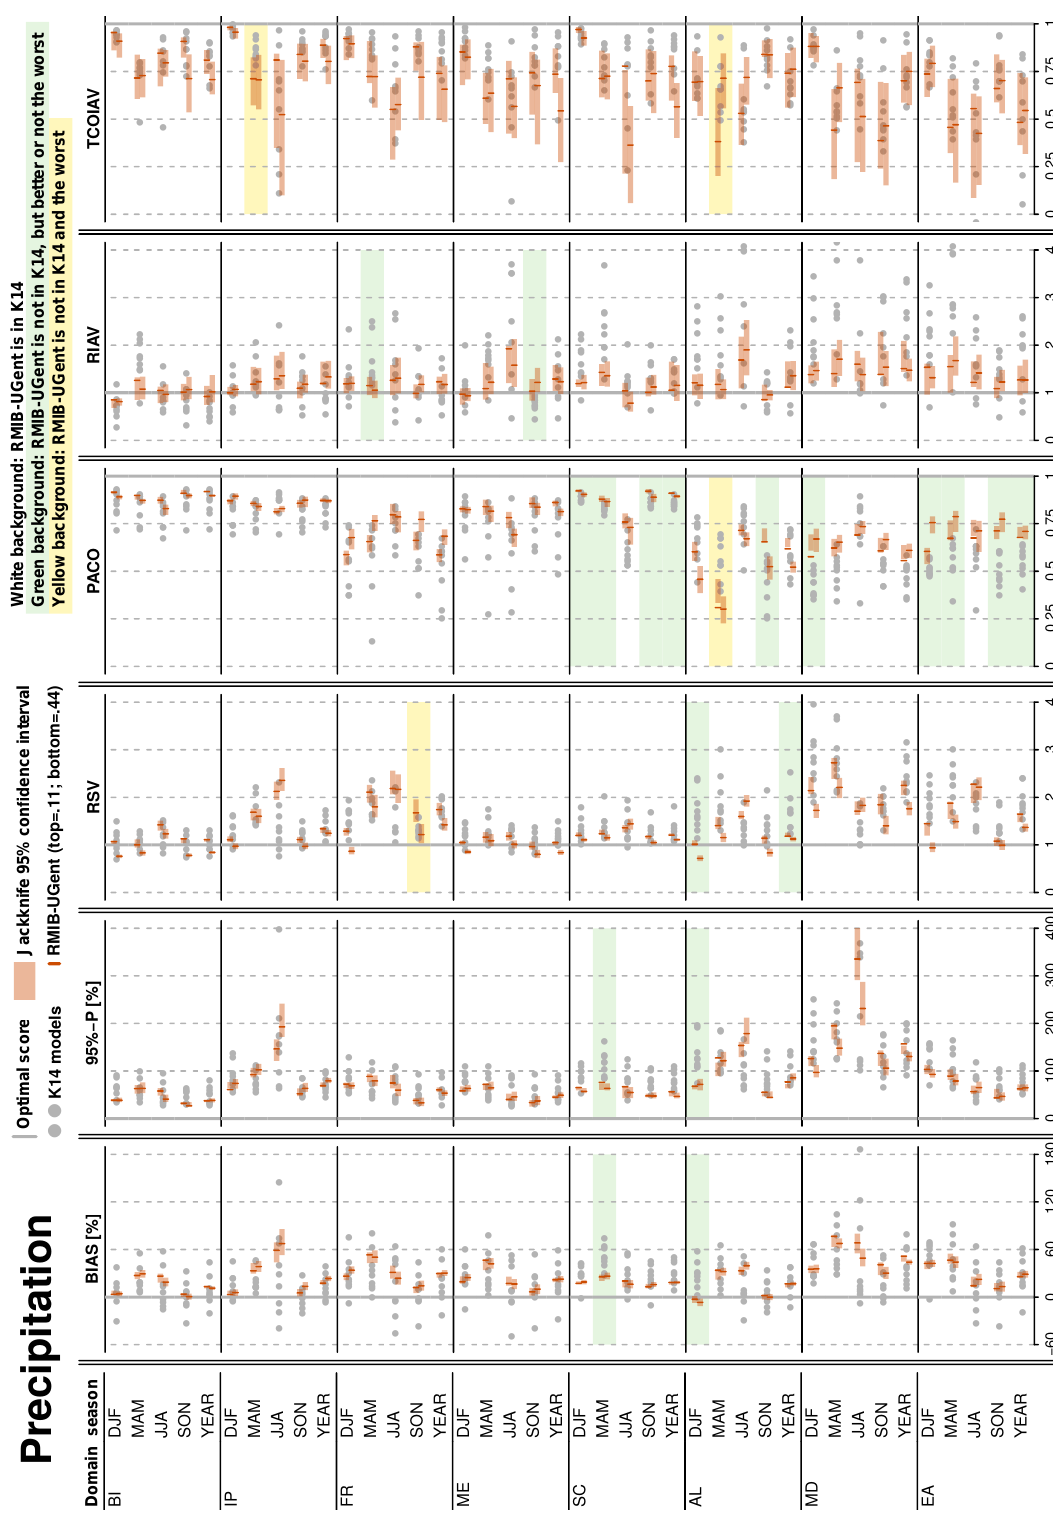
Figure 5. Scores for precipitation for all domains (first column), seasons (second column) and